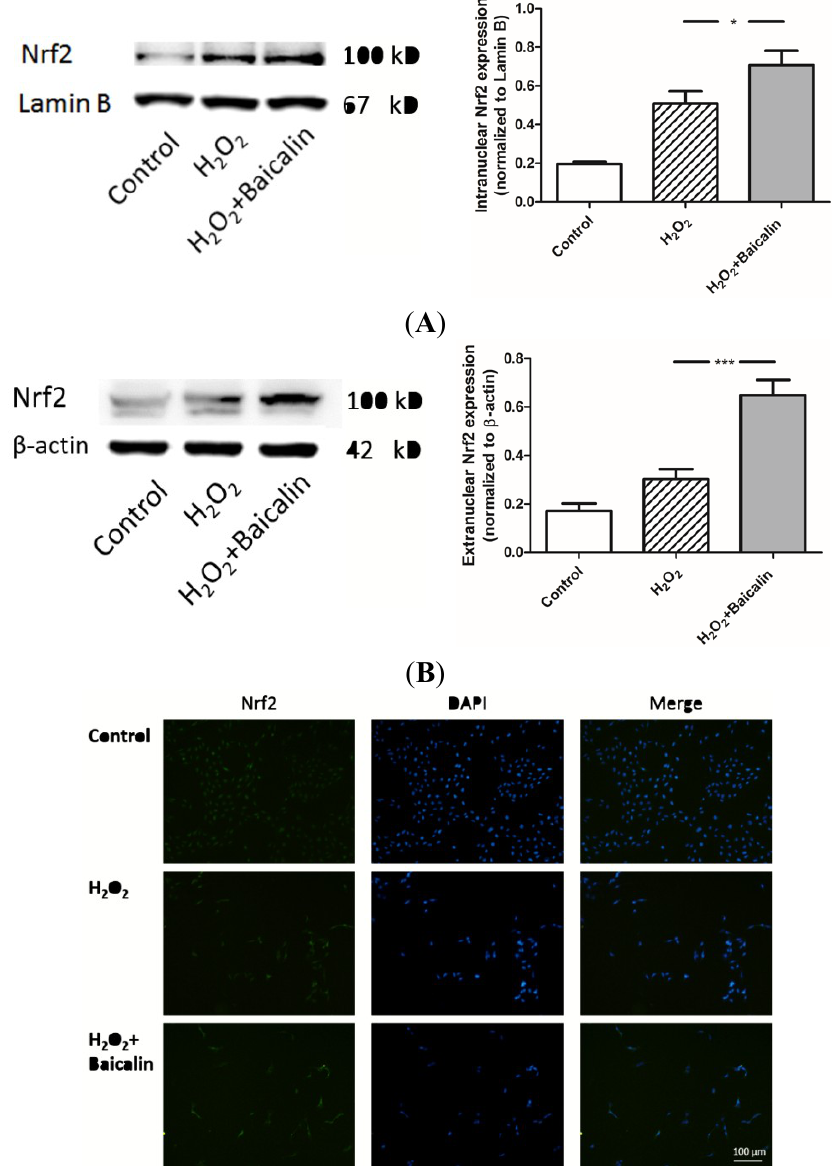
Figure 6. Intranuclear and extranuclear expression of Nrf2 in cultured HK-2 cells. Western blot analysis showed both intranuclear ( A ) and extranuclear ( B ) Nrf2s were increased by H O treatment; In addition, Baicalin pretreatment further promoted the expression of 2 2 Nrf2. Immunocytochemistry ( C ) showed that a brighter color of Nrf2 is observed in the H O + Baicalin group than the color in the H 2 2 the group with H O treatment, n = 2 2